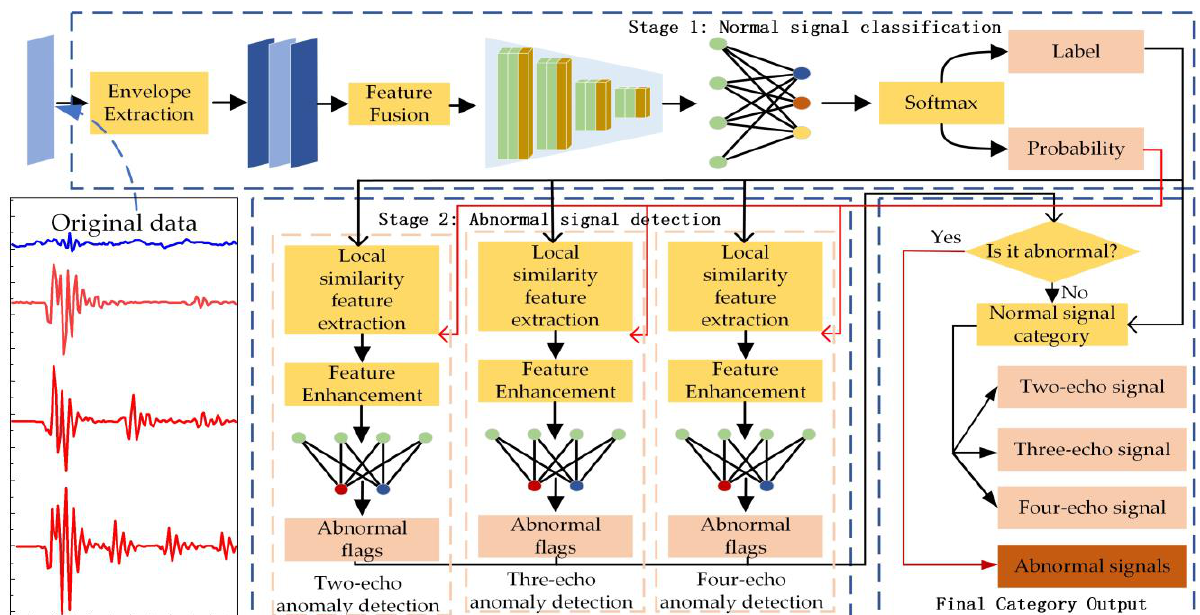
Figure 2. Overall framework of the two-stage ultrasound signal recognition method, based on the envelope and local similarity features.